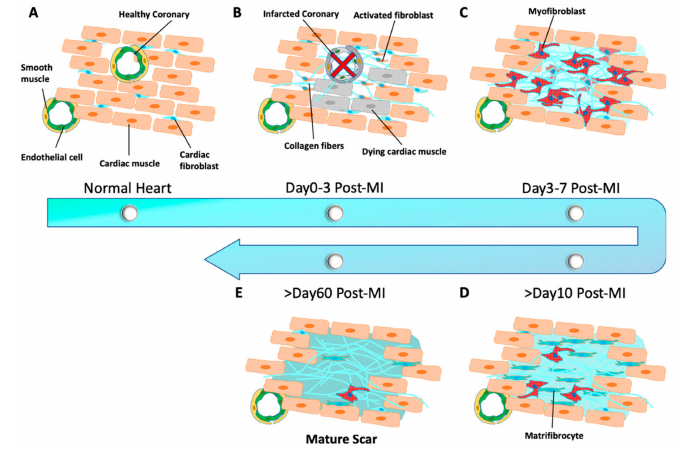
Figure 1. Schematic representation of cardiac remodeling progression in post-infarction mouse hearts. ( A ) Cardiac fibroblasts are normally quiescent in the heart. ( B ) Cardiac fibroblasts are activated and quickly reenter the cell cycle after myocardium infarction (MI). ( C ) Cardiac fibroblasts di ff erentiated into myofibroblasts. ( D ) Matrifibrocytes are further di ff erentiated from myofibroblasts. ( E ) A mature scar is formed to mechanically support and protect the